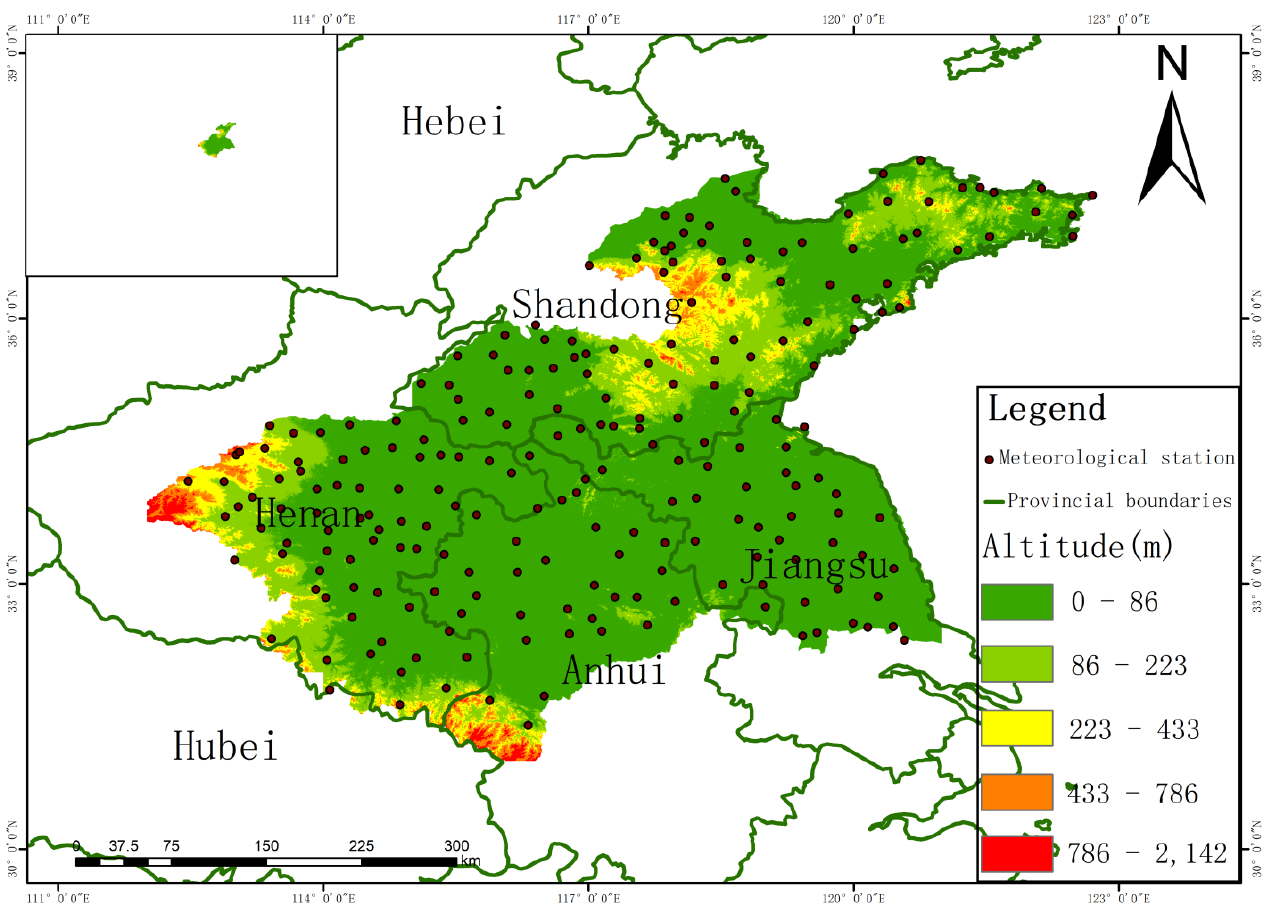
Figure 1. Geographical location map of the Huaihe River Basin.